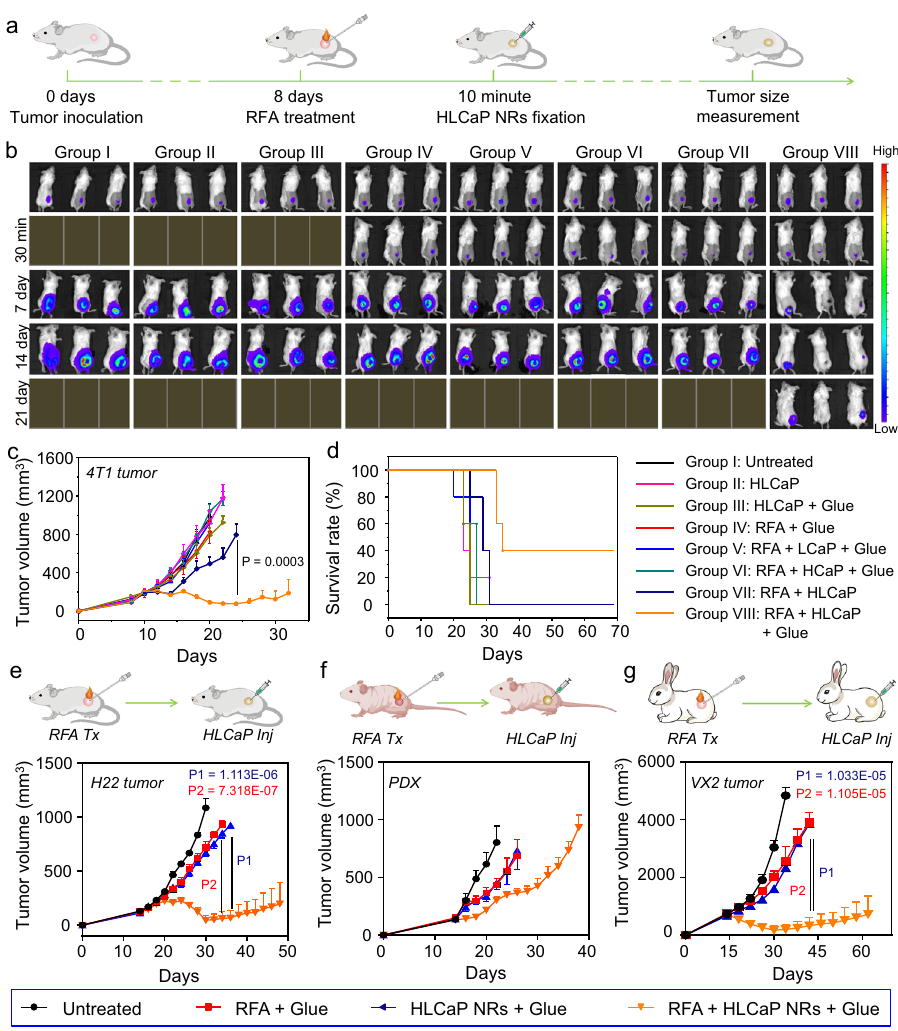
Fig. 5 In vivo antitumor therapeutic ef fi cacy of sequential RFA and HLCaP NRs fi xation. a Schematic illustration of the in vivo therapeutic schedule on mouse 4T1 tumor model. b In vivo representative bioluminescence imaging of different groups of mice post different treatments as indicated. c , d Tumor growth curves ( c ) and corresponding mobility-free survival rate ( d ) of 4T1 tumor-bearing mice post different treatments as indicated. The mice were set as dead when their tumor volume was larger than 1000 mm 3 . e – g Schematic illustrations and corresponding tumor growth curves of murine H22 tumors ( e ), human liver cancer PDX tumors ( f ), and rabbit VX2 tumors ( g ) post different treatments as indicated. Data of Fig. b , e – g were represented as mean ± SEM, n = 5 biologically independent animals in Fig. c – f , n = 4 biologically independent rabbits in Fig. g . P values calculated by the two-tailed student ’ s t -test are indicated in the fi